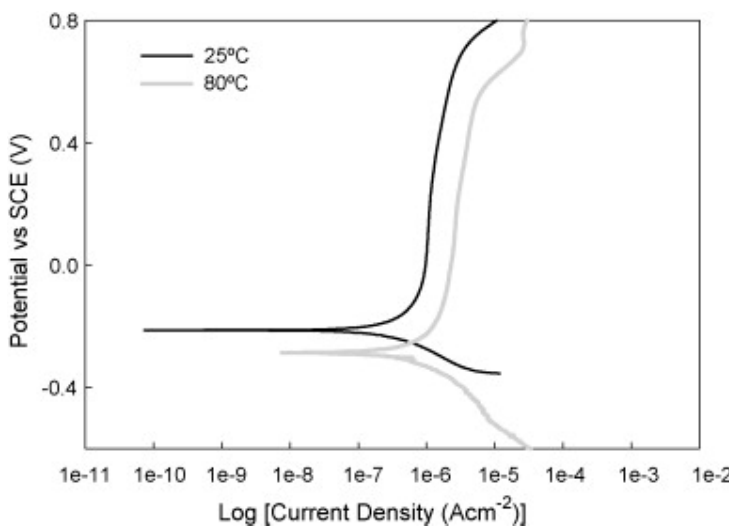
Figure 16. Comparison of SS 316 behavior at 25 °C and 80 °C in 0.5M sulfuric acid, pH = 4 and oxygen bubbled. Reprinted from [183] copyright (2007), with permission from Elsevier. Table 3. Comparison of materials at different temperatures in 85% H 3 PO 4 . Reprinted from [163] copyright (2010), with permission from Elsevier.